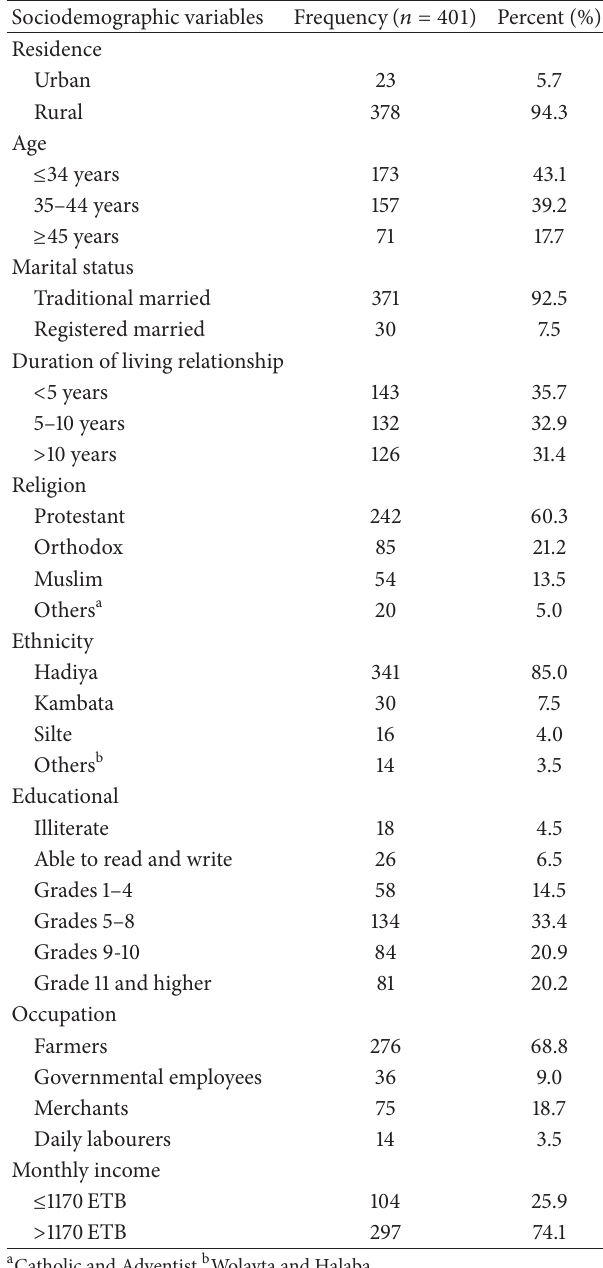
Table 1: Showing sociodemographic and economic characteristic of male partners’ involvement in PMTCT of HIV services in Lemo District, Hadiya Zone, southern central Ethiopia,